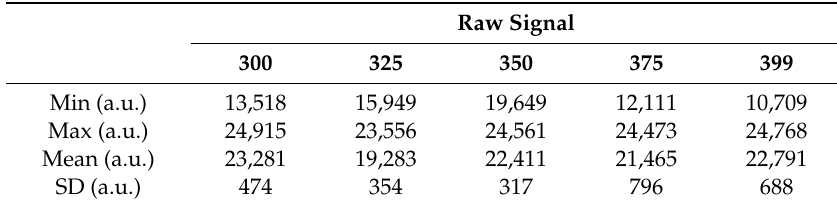
Table 2. Statistical values of the measurement as a train passes through channels 300, 325, 350, 375 and 399.